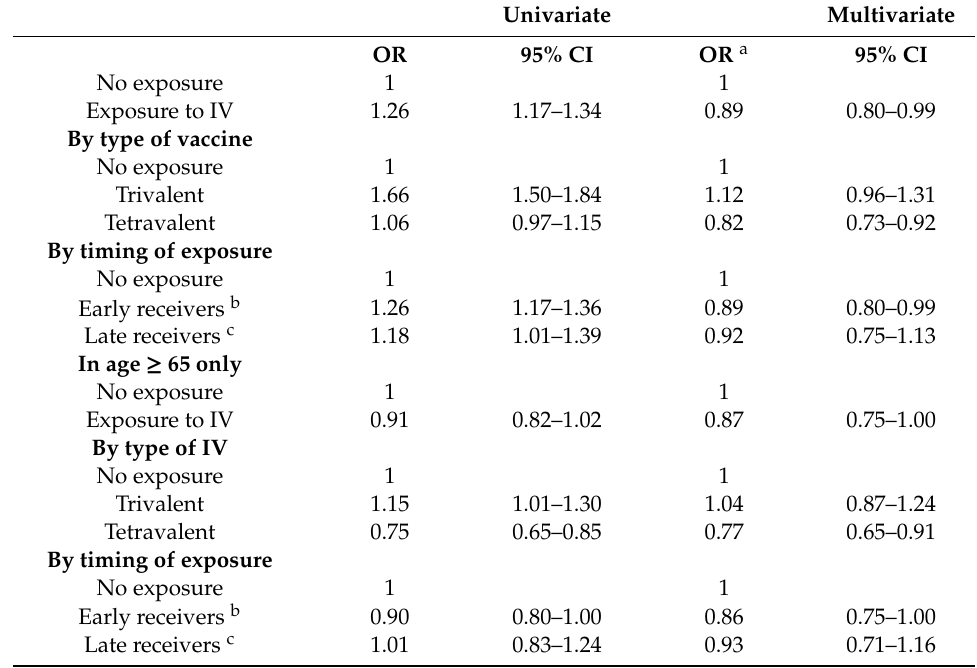
Table 2. Swab test, according to previous exposure to influenza vaccine (IV). Secondary analyses are in gray background